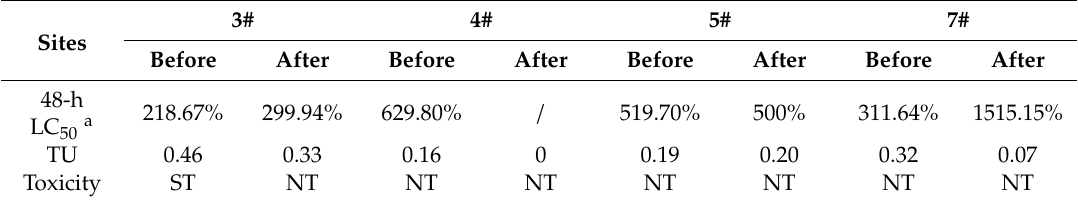
Table 4. Biological toxicity assessment on overlying water by D. magna before and after remediation. Sites